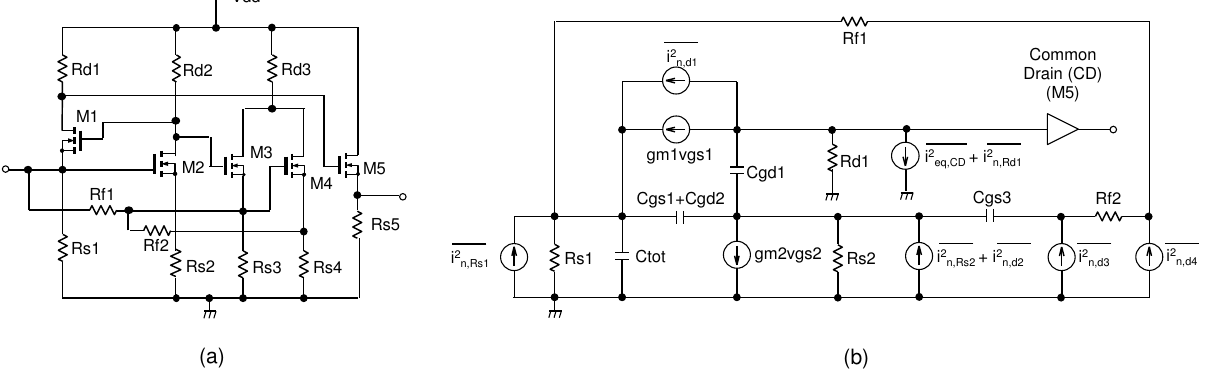
Figure 12. Simplified noise equivalent circuit of the proposed TIA: ( a ) proposed TIA circuit, ( b ) its equivalent noise model.